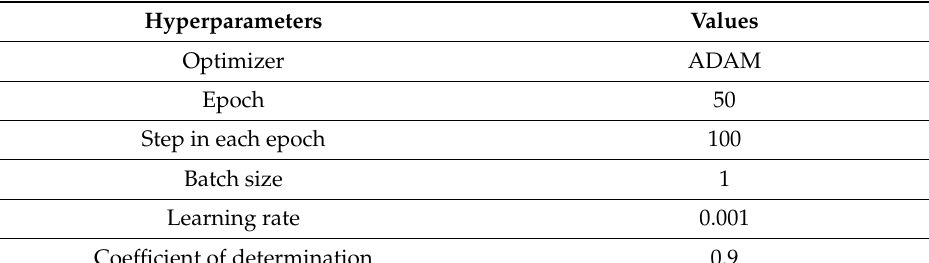
Table 2. Hyperparameters used in model training.